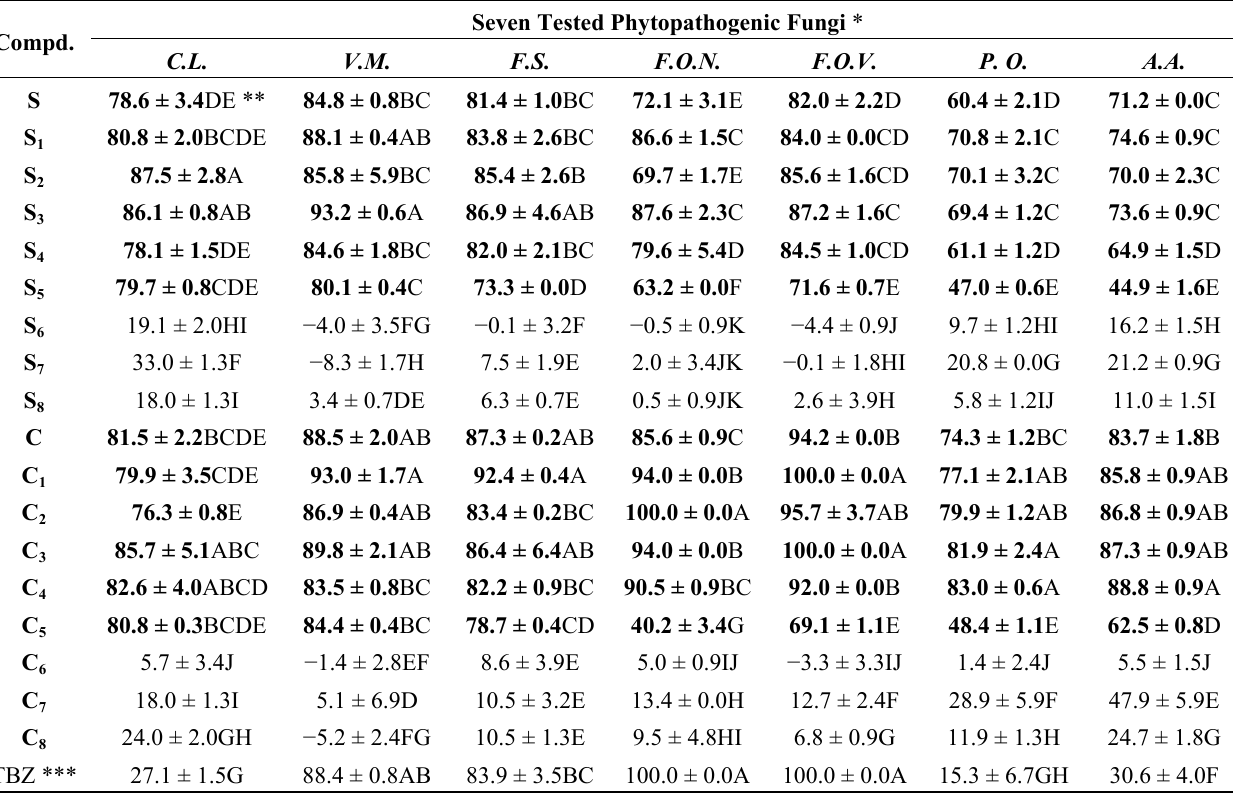
Table 1. Linear Growth inhibitory rates (means ± S.D.%) of 18 compounds against seven phytopathogenic fungi (100 µg/mL).